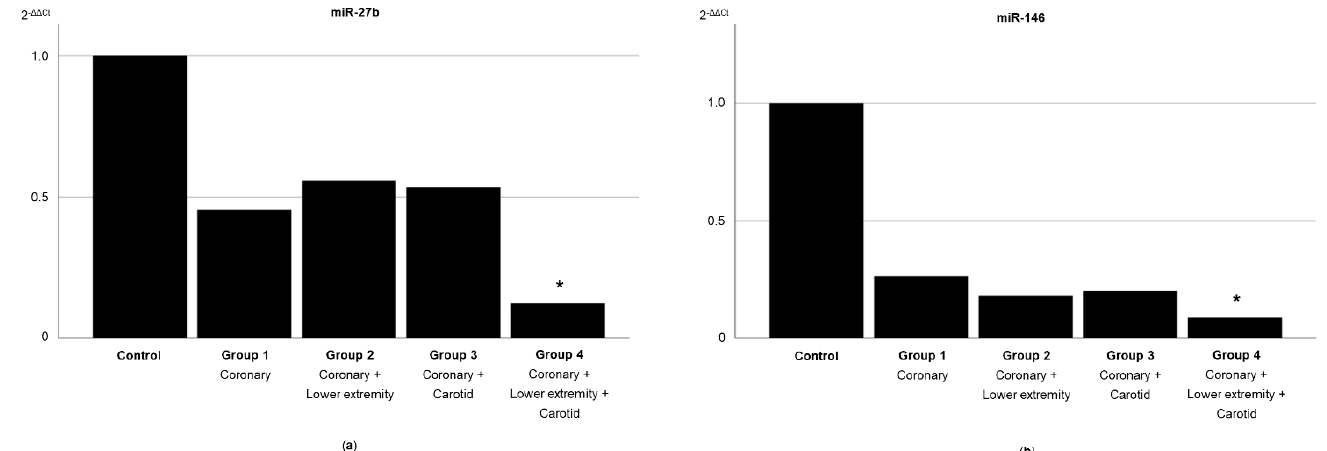
Figure 1. Relative expression of miR-27b and miR-146 according to the systemic extent of atherosclerosis in different territories. The mean relative expression levels of ( a ) miR-27b and ( b ) miR-146 are presented using the Livak method (2 −ΔΔ Ct ), with lower values corresponding to lower expression levels [24]. * p -value < 0.05 vs. controls.